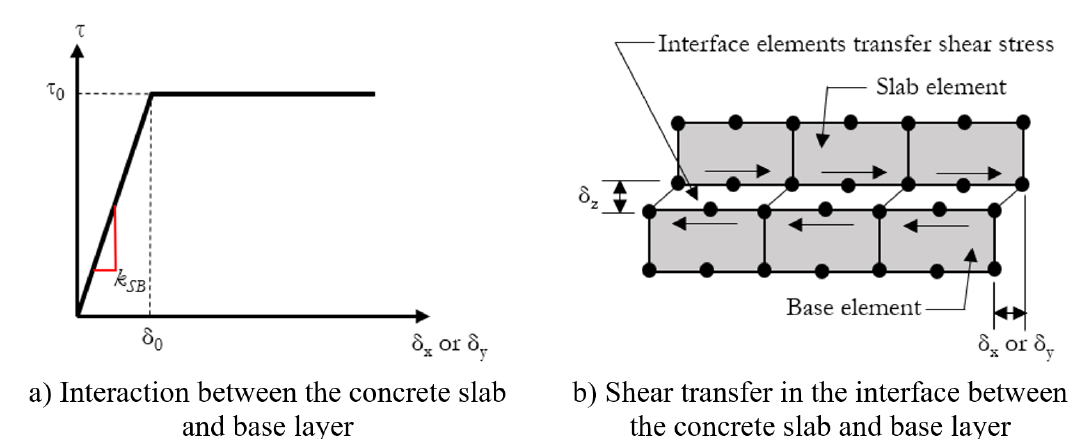
Figure 4. Shear transfer between the concrete slab and base layer modeling in the EverFE 2.25 (Source: adapted from Davids et al.